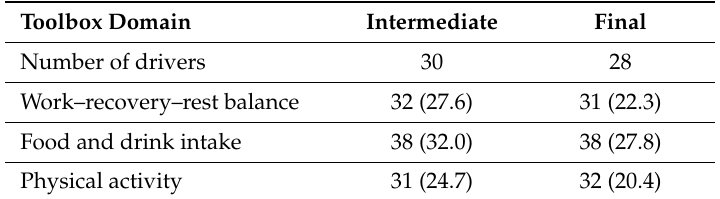
Table 5. Usage (mean % ± SD) of the separate domains in the toolbox in the intervention group in the intermediate and final measurements.